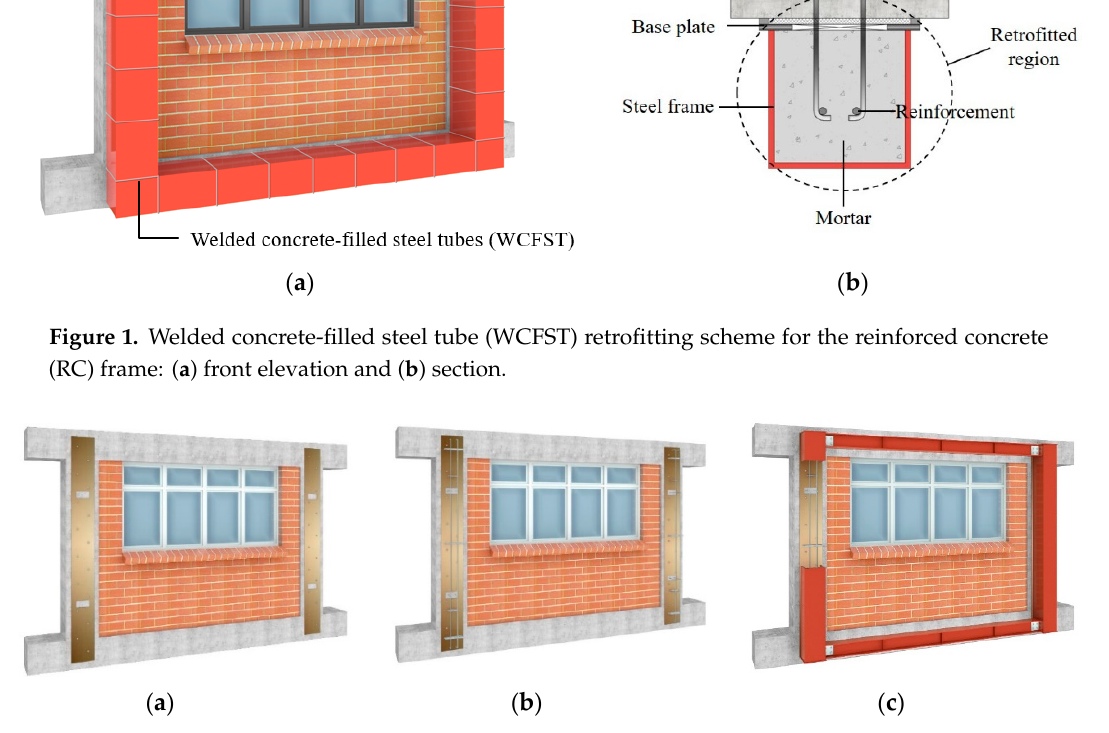
Figure 2. Construction process for retrofitting using the WCFST system: ( a ) installation of base plates, ( b ) bonding of base plates using a chemical anchor and placing of reinforcement, and ( c ) installation of a CFST frame.